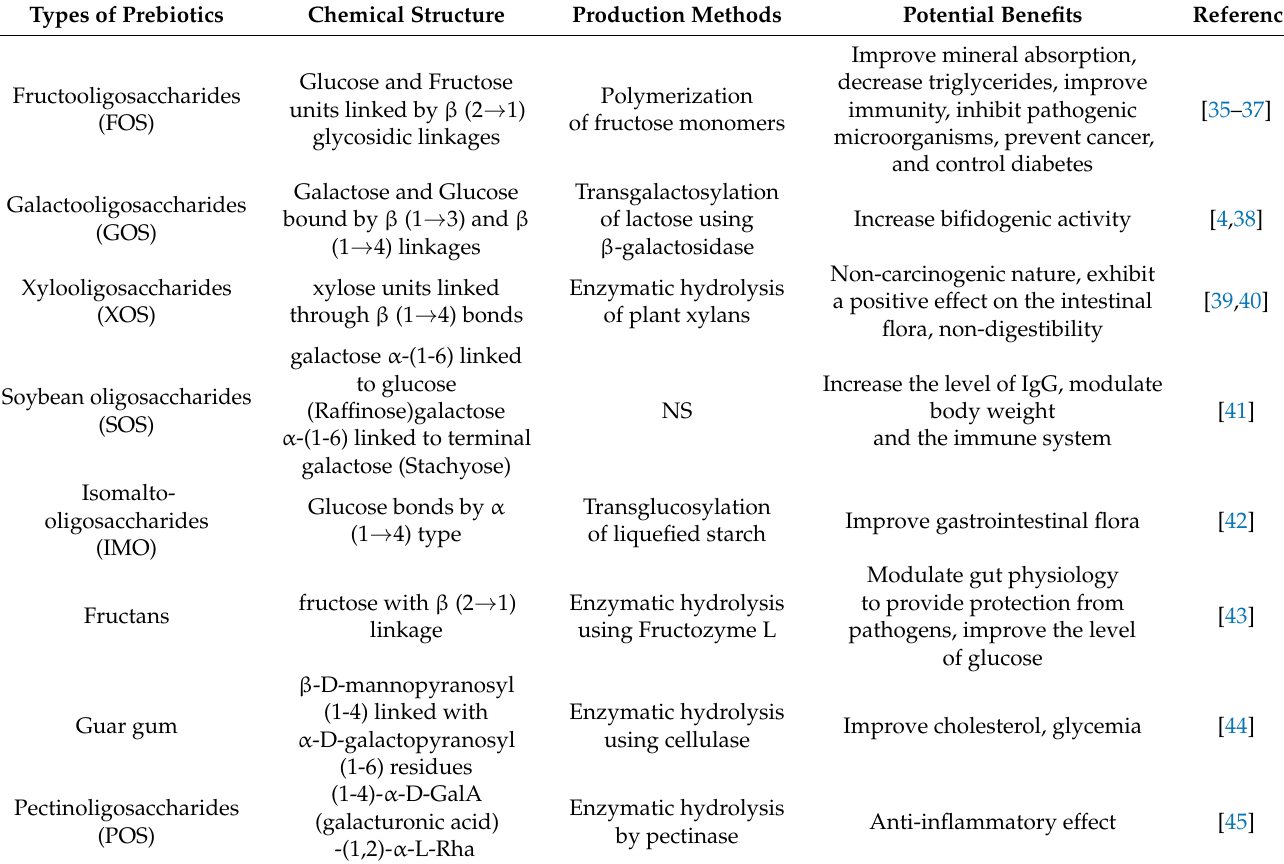
Table 1. Types, structure, production, and potential benefits of